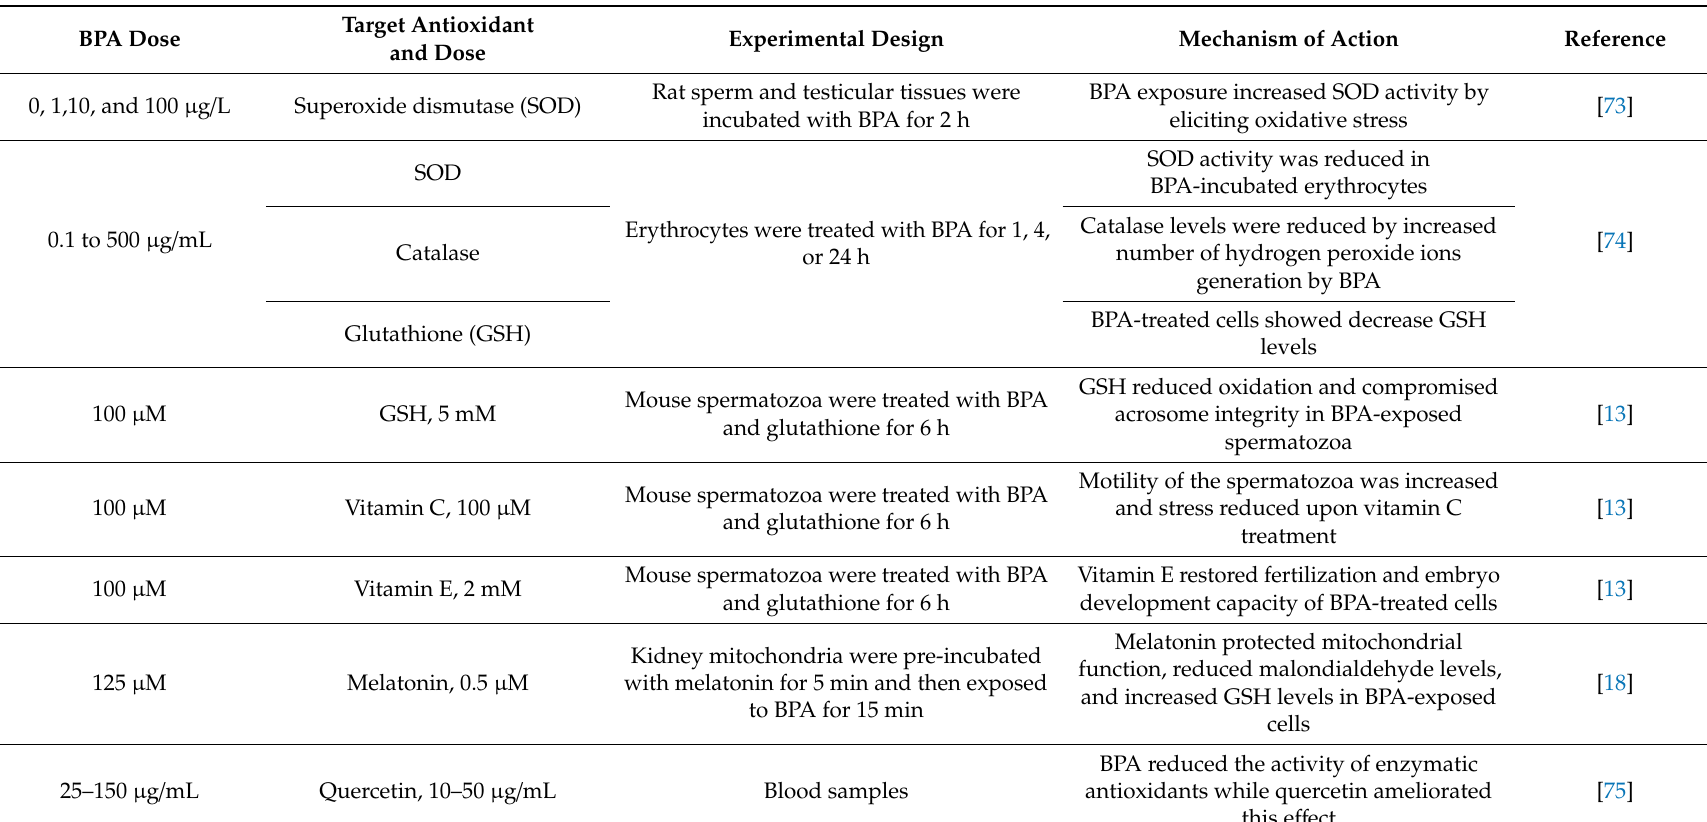
Table 2. Summary of antioxidant e ff ects alleviating bisphenol A (BPA) toxicity: evidence from in vitro